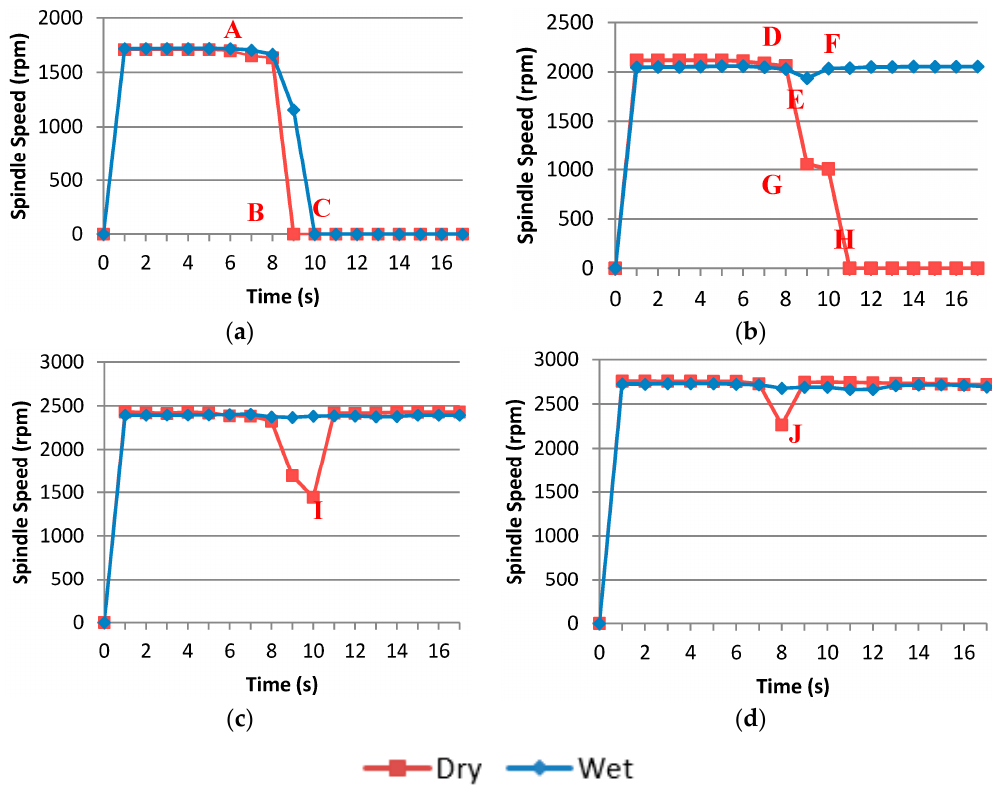
Figure 5. Wet and dry comparisons for initial spindle speeds of ( a ) 1700, ( b ) 2100, ( c ) 2400, and ( d ) 2750 rpm.